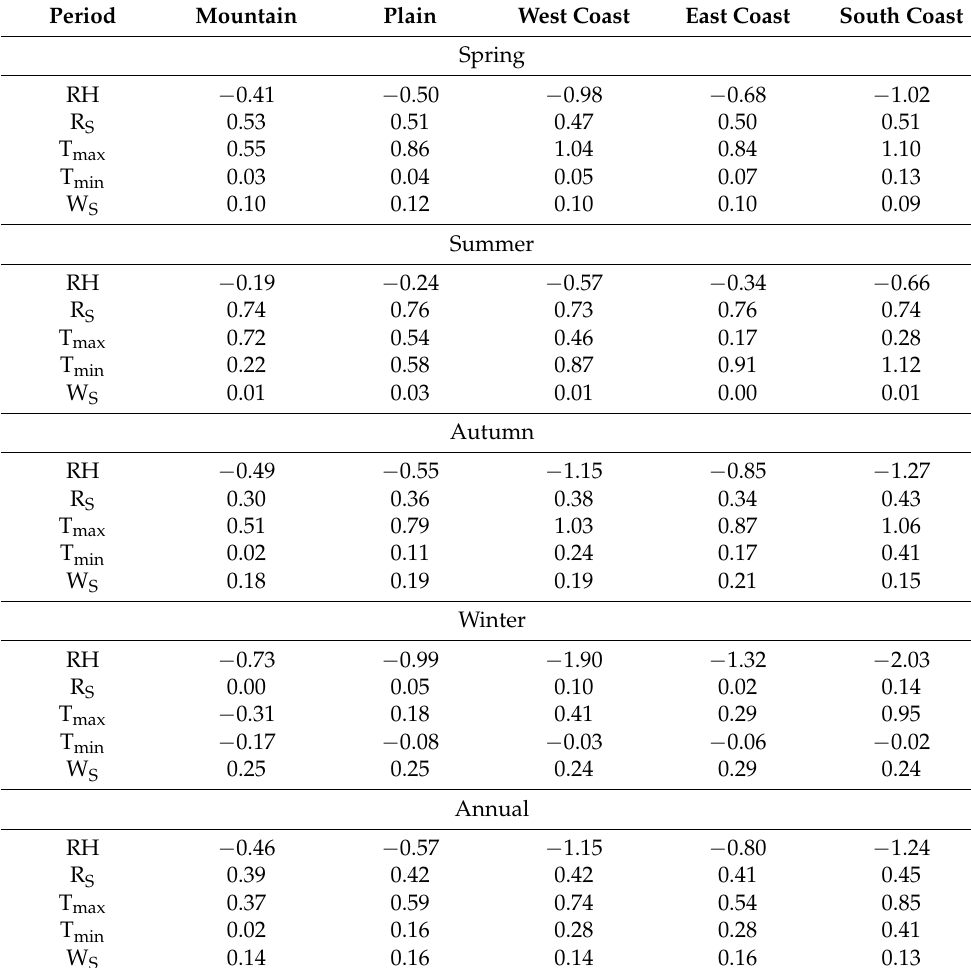
The results of the sensitivity analysis on seasonal and annual scales in